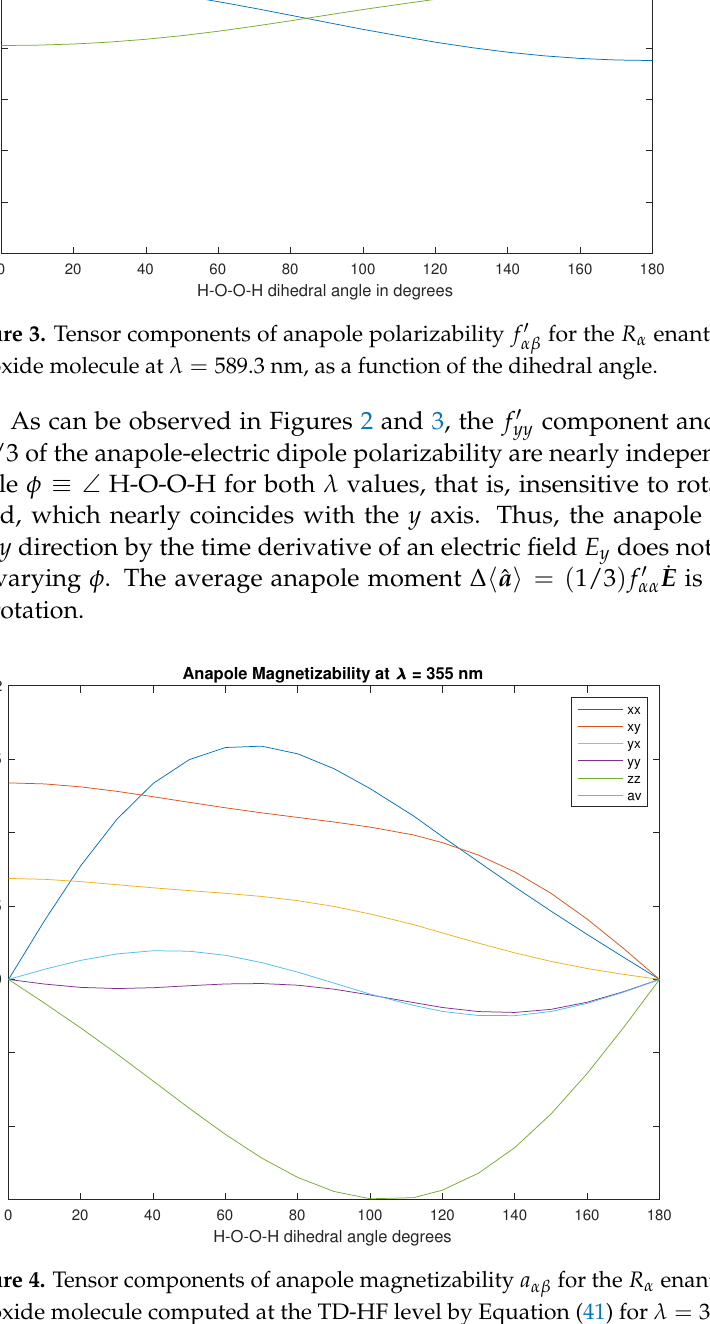
Figure 4. Tensor components of anapole magnetizability a αβ for the R α enantiomer of the hydrogen peroxide molecule computed at the TD-HF level by Equation (41) for λ = 355 nm, as a function of the dihedral